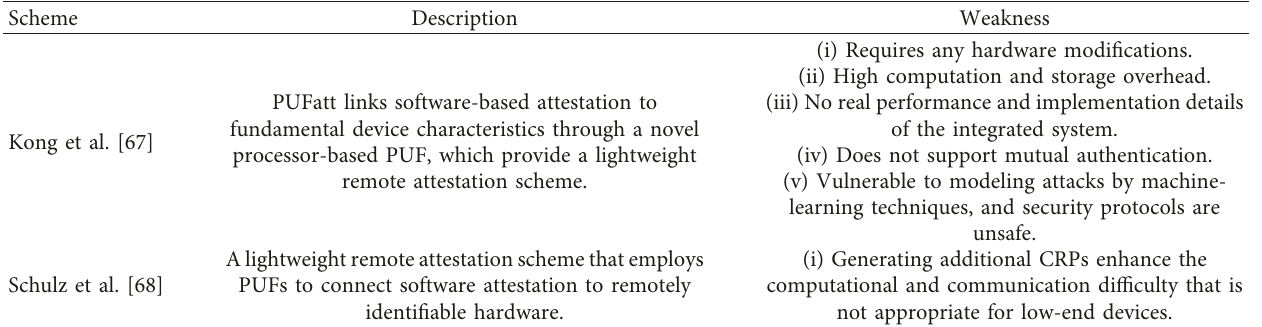
Table 4: Developed attestation schemes and the